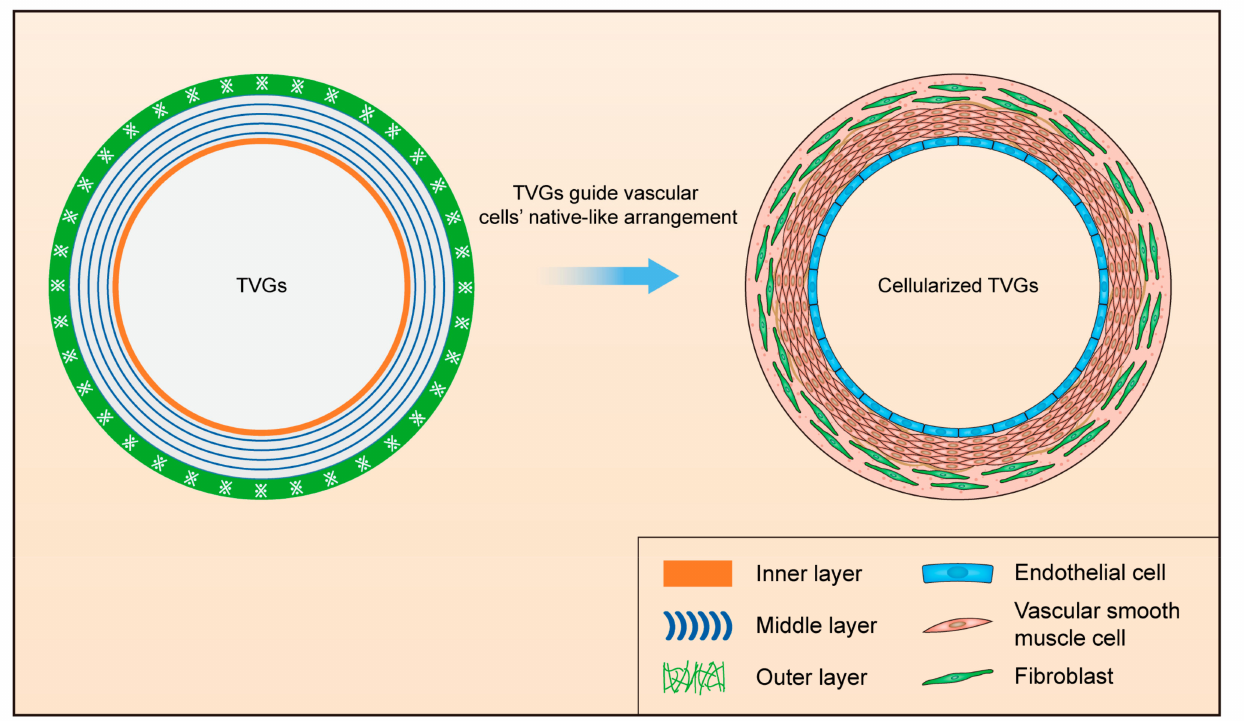
Figure 5. Schematic illustration of designing TVGs with a stratified biomimetic structure to guide the native-like arrangement of vascular